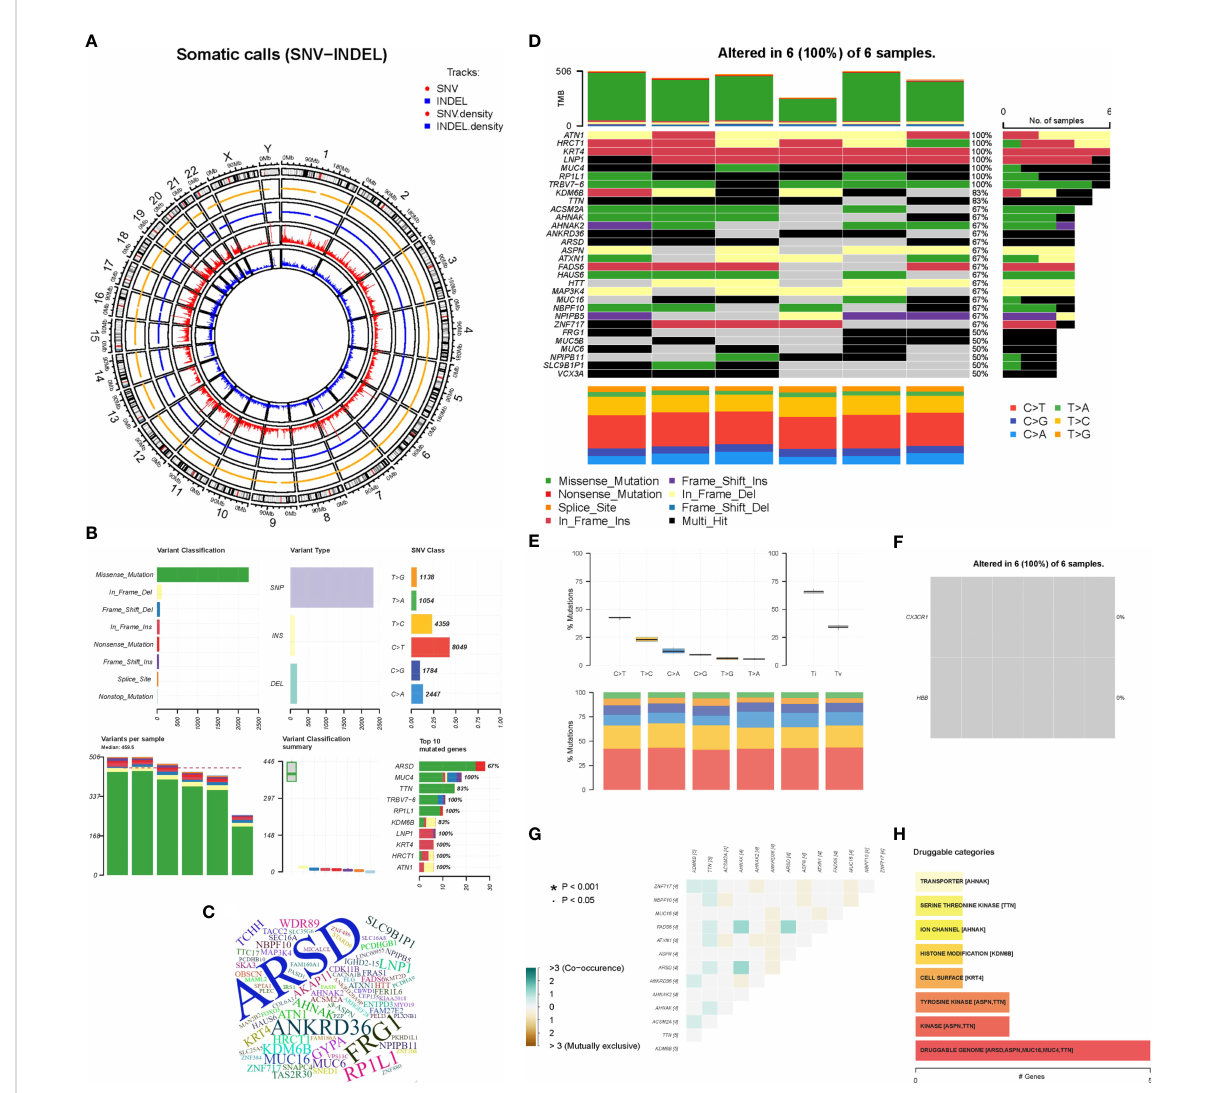
FIGURE 9 Whole Exome Sequencing analysis. (A) The circos plot of SNV-INDEL, the two outer tracks show the position of SNV and INDEL on the chromosome, and the two inner tracks show the distribution density. (B) The overall characteristics of the fi ltered mutation data. (C) The word cloud of the top 100 genes, the larger the font, the higher the variation frequency. (D) The oncoplot belongs to the top mutated 30 genes in each sample, different colors represent different variant classi fi cations. (E) The overall distribution of the six different Ti/Tv in six samples. (F) The mutations of biomarkers ( CX3CR1 and HBB ) in six samples. (G) Relevance Heatmap of the top 13 mutated genes. (H) The bar chart of potentially druggable variants